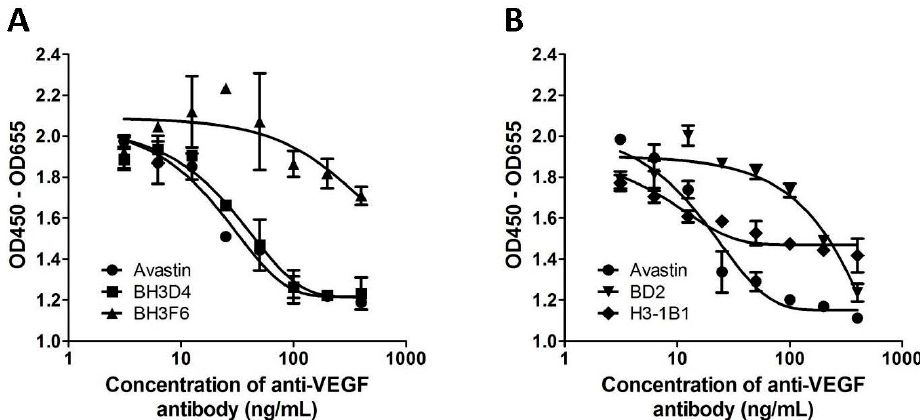
Figure 2. Proliferation assay: Inhibition of VEGF-induced cell proliferation. Avastin and test antibodies were serial diluted and added to the 96-well tissue culture plates. The antibody was mixed with VEGF and incubated at room temperature for 30 min. HUVEC cells were harvested and added to each well. After incubation, WST-1 was added to determine the absorbance at 450 and 655 nm. ( A ) An example of anti-proliferation effects (BH3D4); ( B ) An example of an atypical curve (H3-1B1).